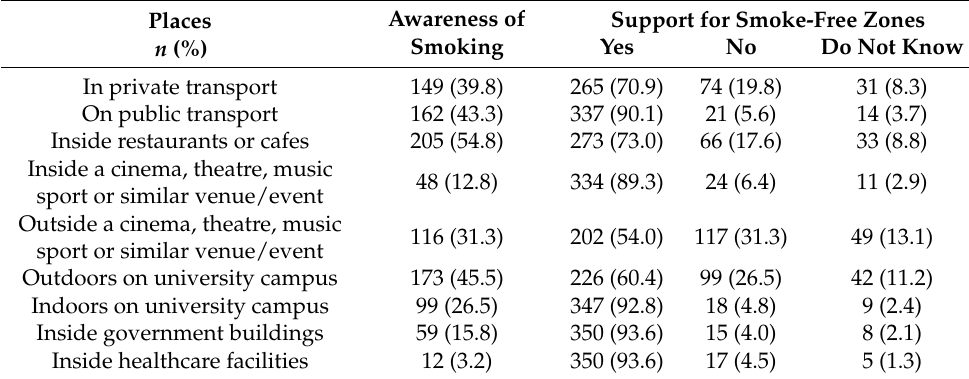
Table 2. Awareness of smoking in the past 30 days at a range of places ( n = 374).